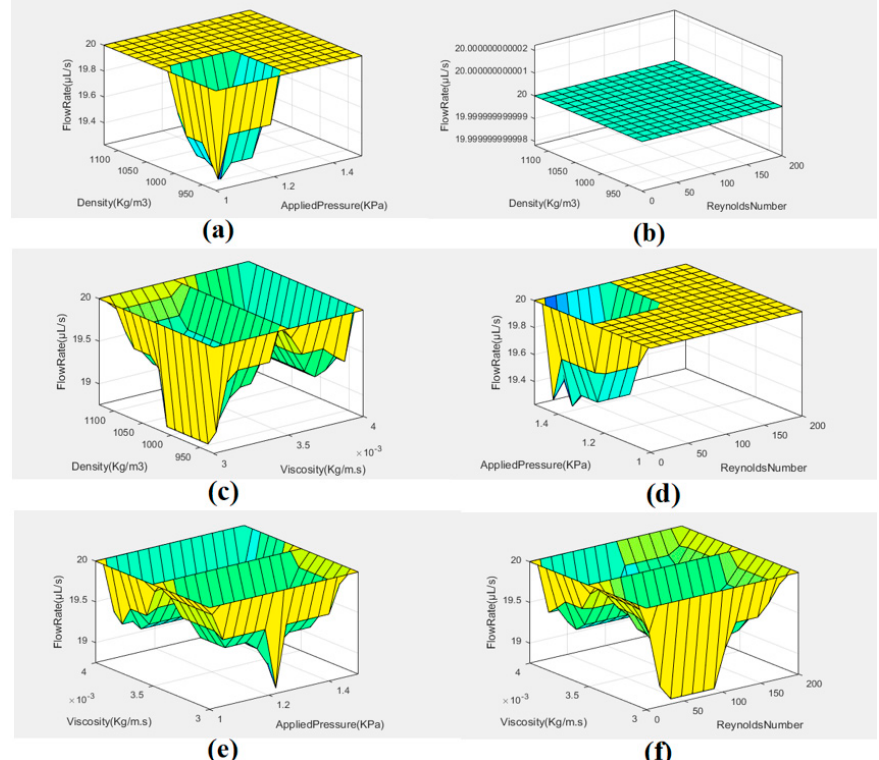
Figure 4. 3D graphical variations with inputs Reynolds number, applied pressure, viscosity, and density with flow rate as output. ( a ) Change for applied pressure with density and flow rate as output. ( b ) Variation for Reynolds number with density and flow rate as output. ( c ) Change for viscosity with density and flow rate as output. ( d ) Variation for applied pressure with Reynolds number and flow rate as output. ( e ) Difference for applied pressure with viscosity and flow rate as output. ( f ) Variation for Reynolds number with viscosity and flow rate as output.